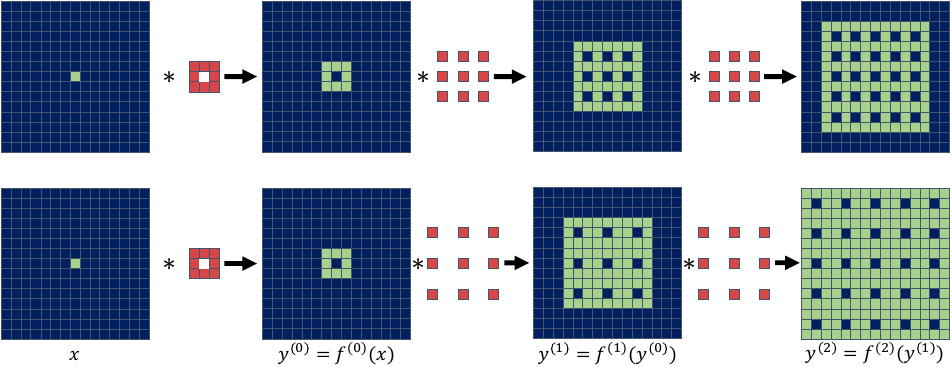
Figure 3. An example of dependency between the pixels in the input ( x ) and the output ( y ) im- ages with one 3 × 3 donut convolution filter and d -dilated convolution. Each row represents the dependency visualization with two 2-dilated convolution and two 3-dilated convolution layers, respectively. The green pixels indicate the pixel locations that have dependency with x i , j (the center pixel in x ). The red pixels represent the trainable variables of the convolution kernels. The blue pixels indicate the area independent of x i , j . This figure shows the intermediate convolution processes of y = f ( x ) = f ( 2 ) ( f ( 1 ) ( f ( 0 ) ( x ))) from the input image to the output